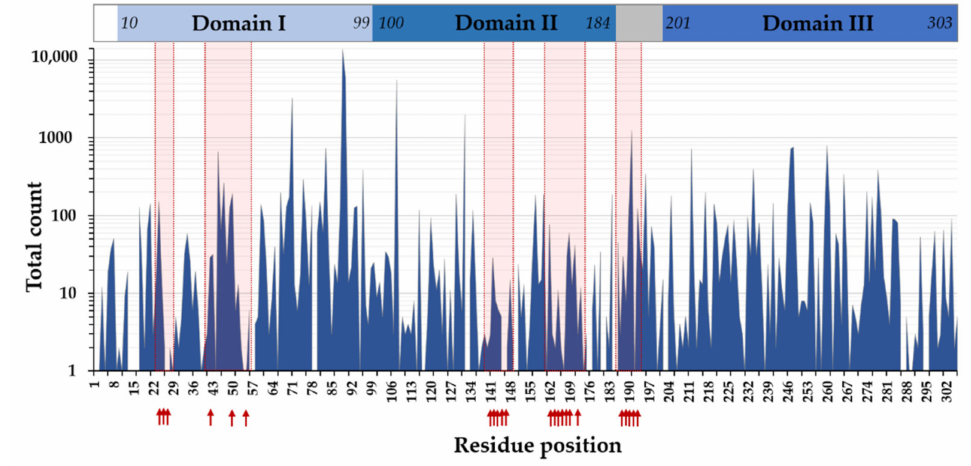
Figure 3. SARS-CoV-2 Mpro sequence variations based on COVID-3D database. The schematic representation of domain organization is also represented, and the arrows show ligand-binding active-site residues based on Table 1.